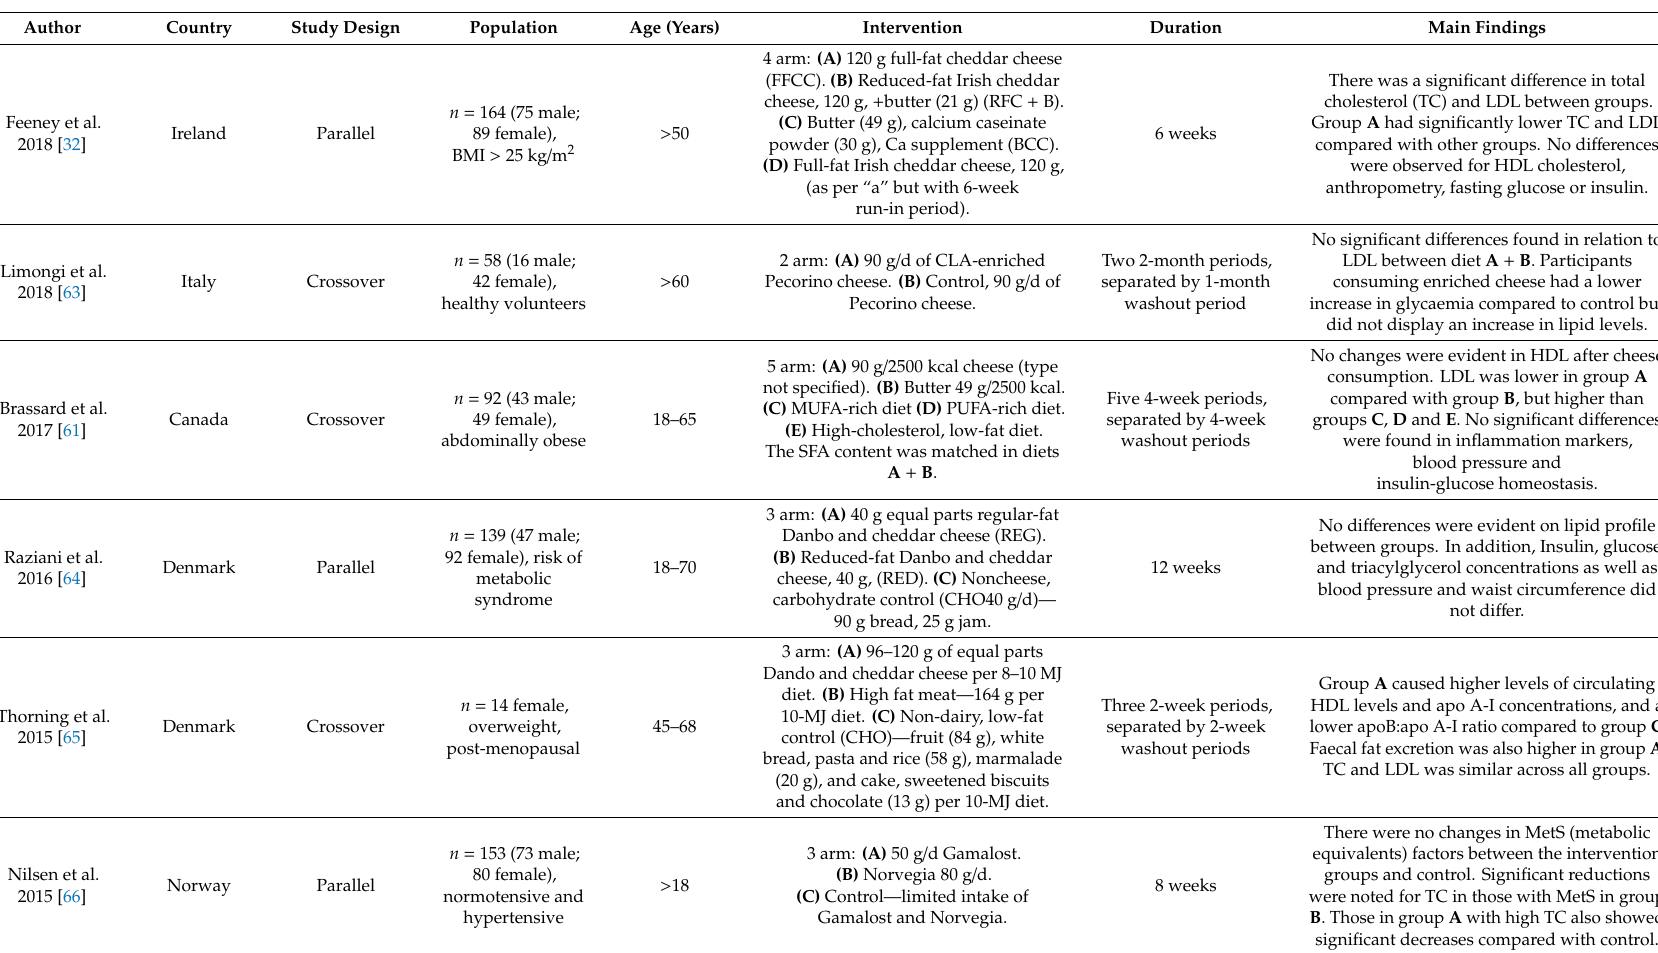
Table 2. Randomised controlled trials (RCT) demonstrating an e ff ect of cheese consumption on markers of metabolic health and CVD